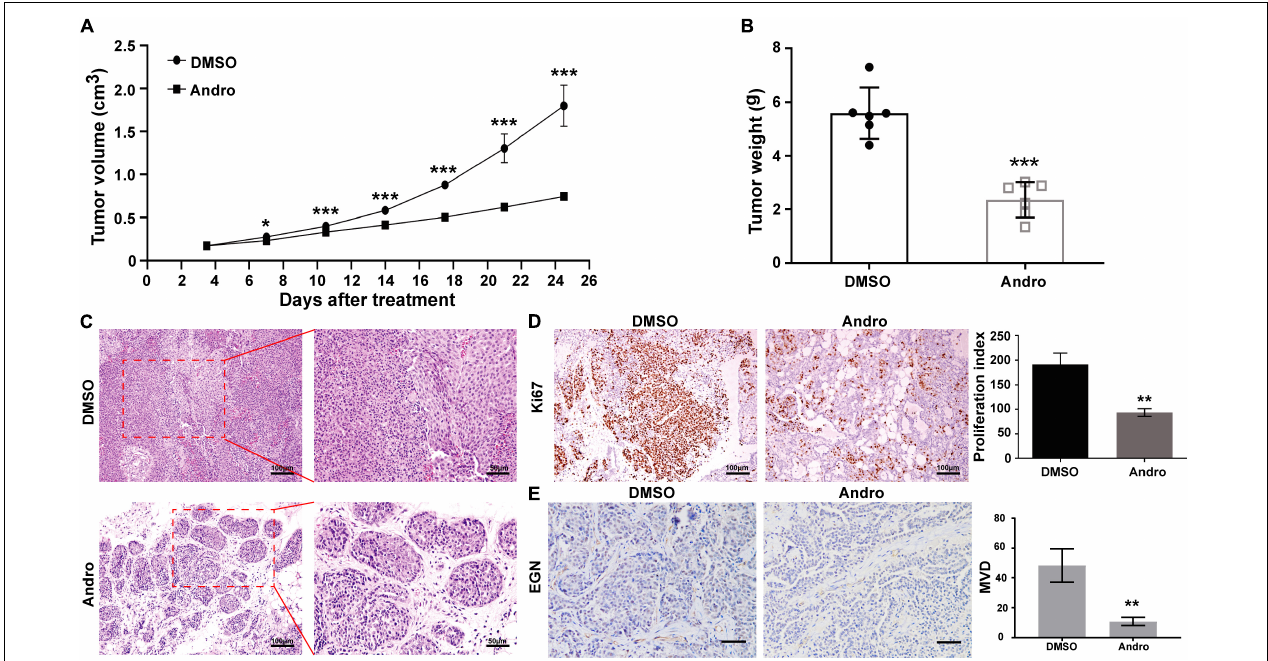
FIGURE 2 | Andrographolide (Andro) suppresses the tumor growth of MMTV-PyMT mice. (A) Tumor volume, (B) tumor weight, (C) tumor morphology, (D) Ki67, and (E) EGN expression detected in treatment with Andro or dimethyl sulfoxide (DMSO). Quantitative data are expressed as the mean ± SD ( n = 6). Significant effect: * P < 0.05; ** P < 0.01; *** P < 0.001.